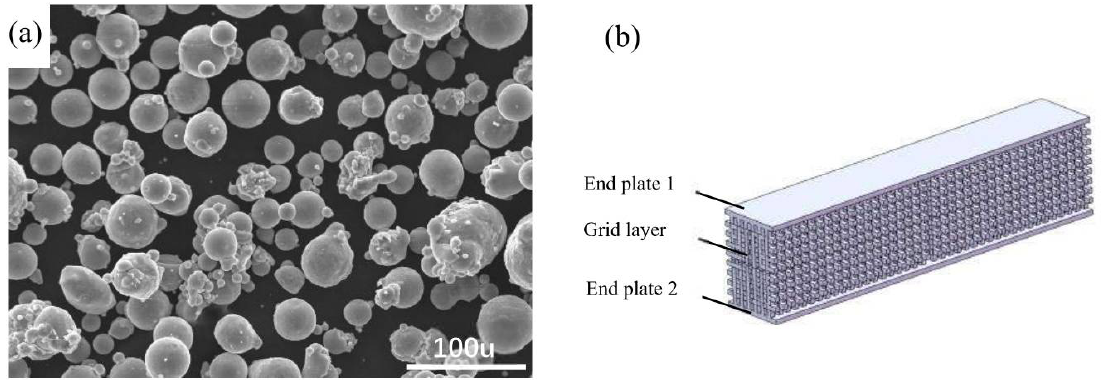
Figure 1. Material and structure of specimens: ( a ) AlMgSc alloy powder after atomization spray forming; ( b ) schematic diagram of specimen model.